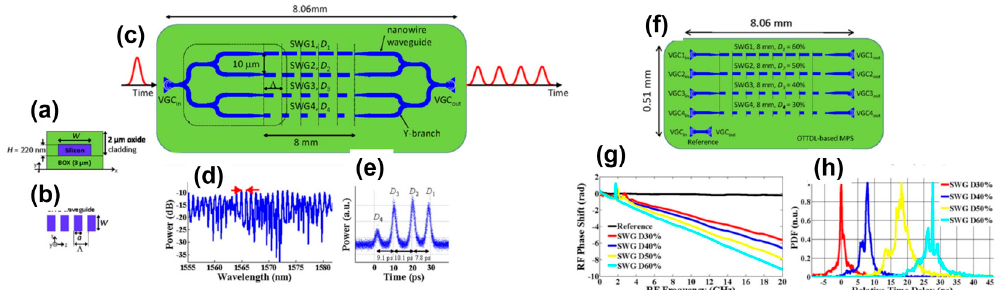
Figure 9. ( a ) The waveguide cross-section. ( b ) Parameters of the subwavelength grating (SWG) waveguide. ( c ) Schematic of the fabricated 4-tap optical true time delay line (OTTDL) structure based